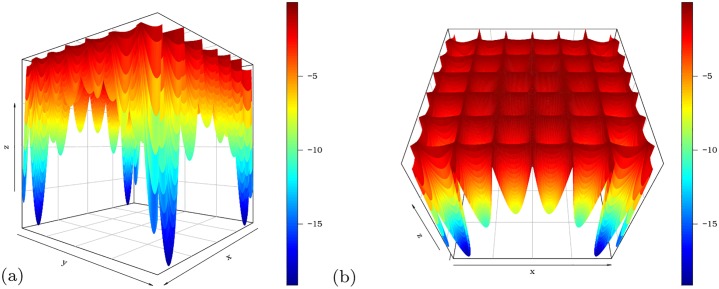
Hölder function at two different angles.